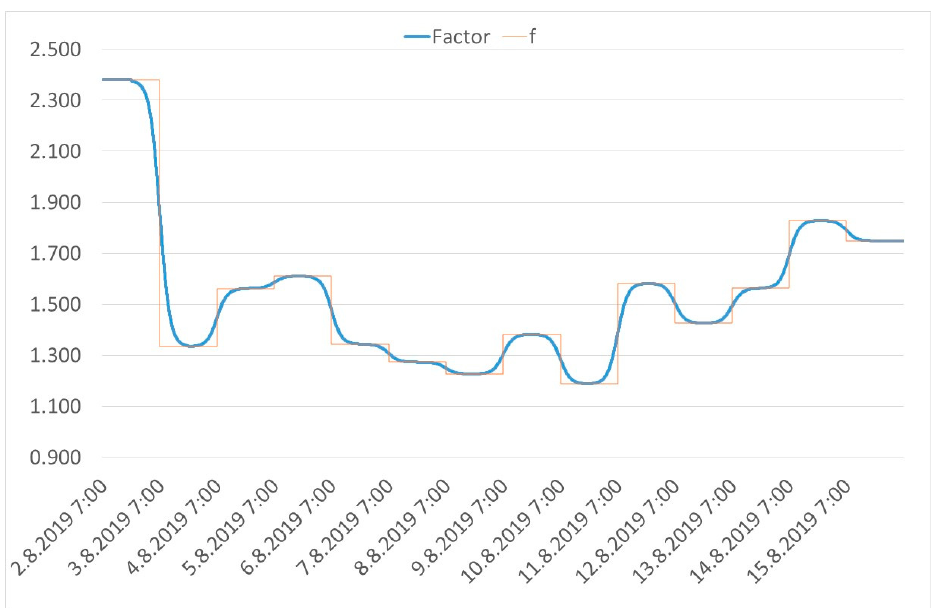
Figure 5. A comparison of the factors for the locality Tyrš ů v sad from 2.8.2019 7:00:00 to 16.8.2019 6:59:00.